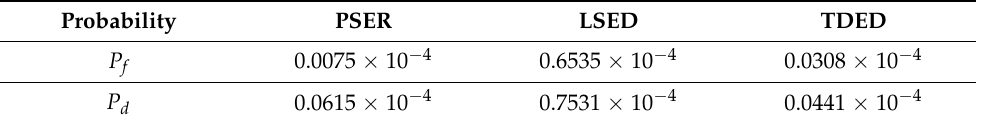
Table 1. Mean square errors (MSEs) between actual and theoretical probabilities for narrow-band